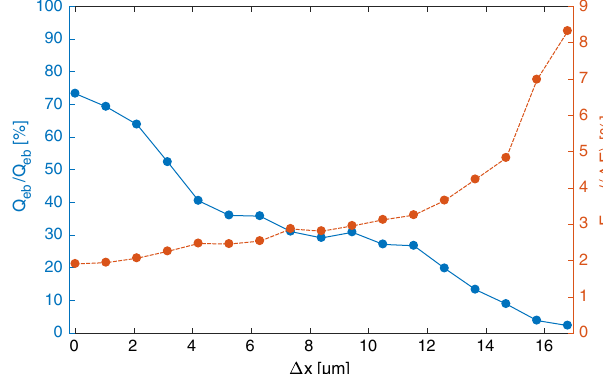
~ Q (blue FIG. 10. Ratio of witness beam charge with emittance pre- ~ Q=Q served, (blue symbols, line), as a function of beam offset, with relative energy spread of the accepted charge (red symbols, dashed line), after 4 m of